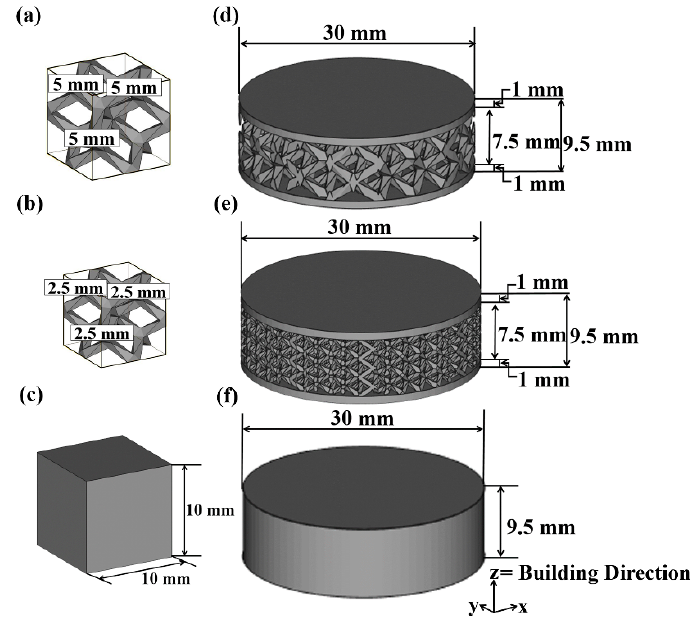
Figure 2. CAD (computer-aided drafting) illustrations of the SLM (selective laser melting) specimens: ( a ) unit cell of Type I lattice sandwich structure (5 × 5 × 5 mm 3 ), ( b ) unit cell of Type II lattice sandwich structure (2.5 × 2.5 × 2.5 mm 3 ), ( c ) bulk cube for comparison, ( d ) Type I lattice sandwich structure for